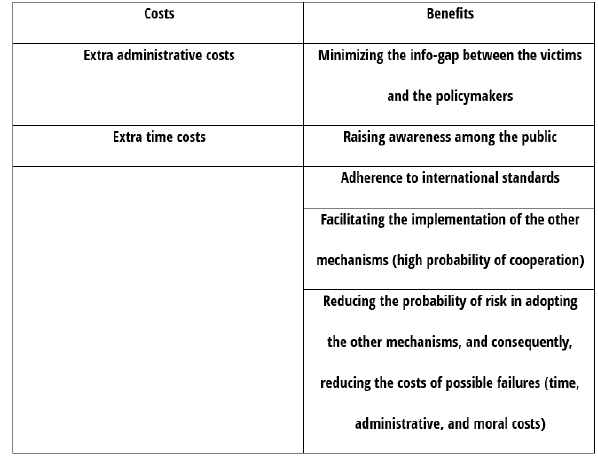
Figure 5: Table (5) Cost-Benefit Matrix of National Consultations as a T.J.